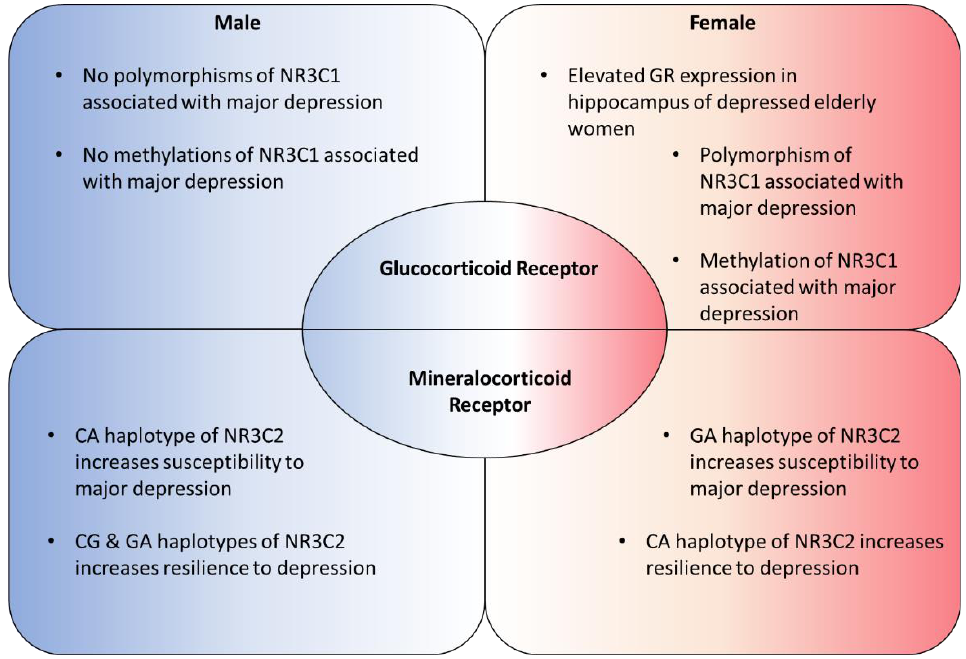
Figure 2. Genetic gender differences in glucocorticoid receptor and mineralocorticoid receptor ex- pressions